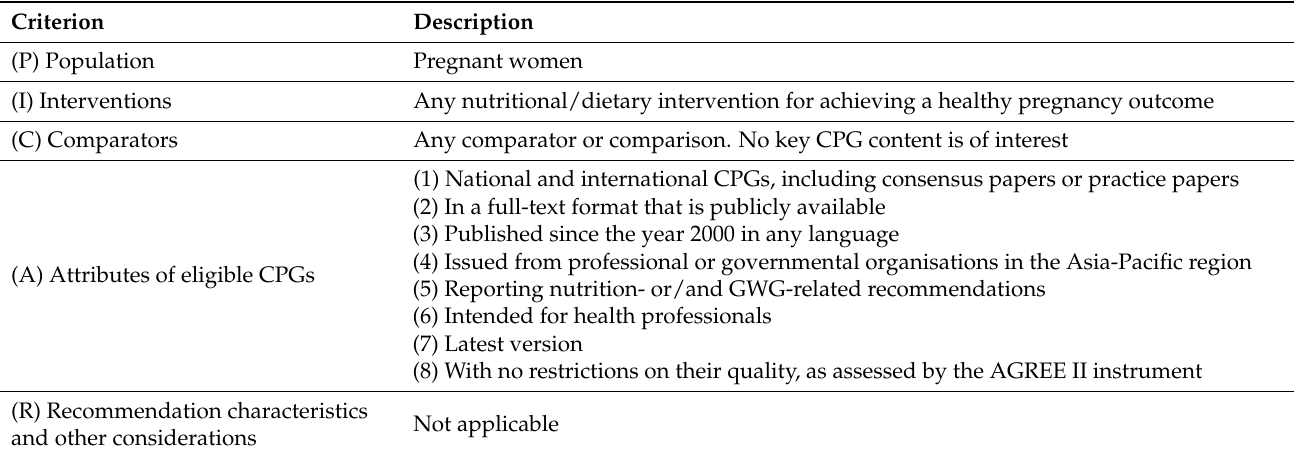
Table 1. PICAR statement for inclusion of